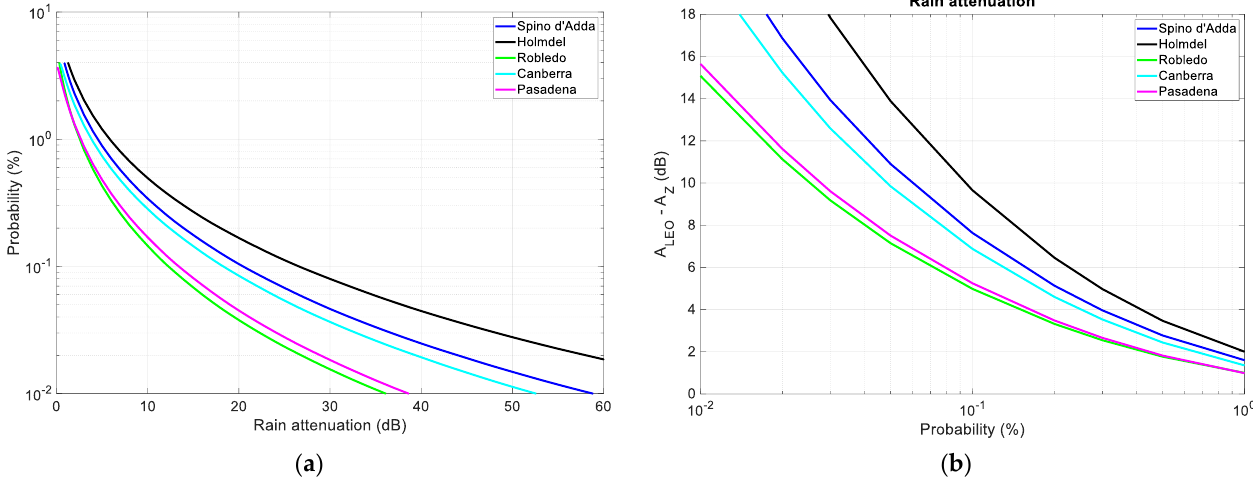
Figure 11. Results predicted with the Global SST model. (a) LEO annual probability distributions (%) of rain attenuation at the reference sites, obtained by weighing the probability distribution of rain attenuation predicted for each elevation angle larger than 20° according to the probability of the elevation angle shown in Figure 10; 39.6 GHz, at the reference sites. (b) The difference 𝐴 𝐿𝐸𝑂 − 𝐴 𝑍 , vs. annual probability (%), between the rain attenuation exceed in the LEO path, 𝐴 𝐿𝐸𝑂 , and the rain attenuation exceed in the GeoSurf path, 𝐴 𝑍 , i.e., at the zenith at the reference sites.